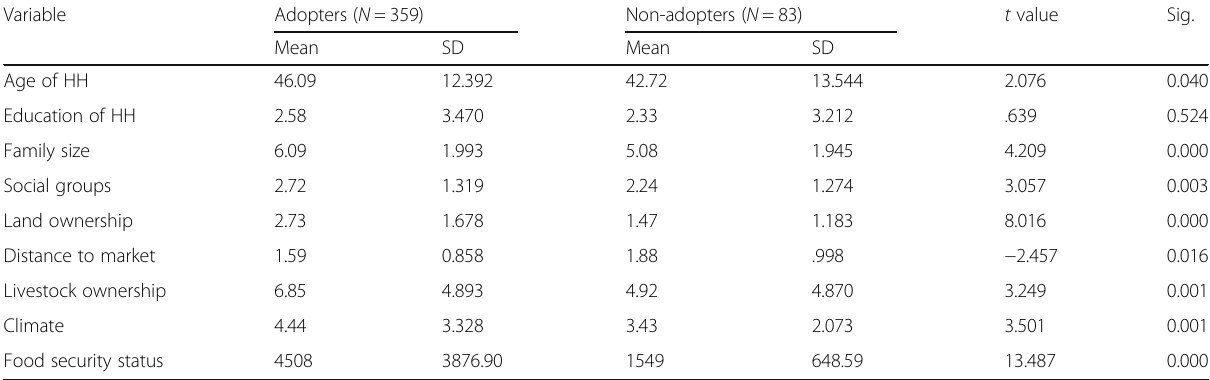
Table 1 Descriptive statistics of continuous variables used in regression Variable Adopters ( N = 359)